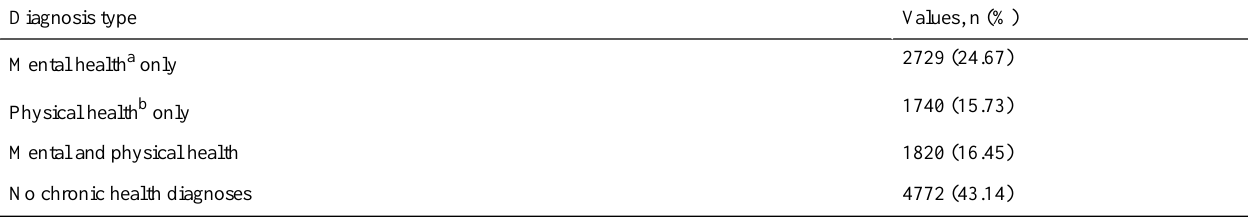
Table 4. Types of self-reported health diagnoses in Calm subscribers (N=11,061).